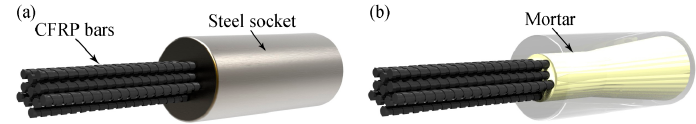
Figure 18. Straight Tube and Inner Cone Anchorage, ( a ) full view and ( b ) transparent view.